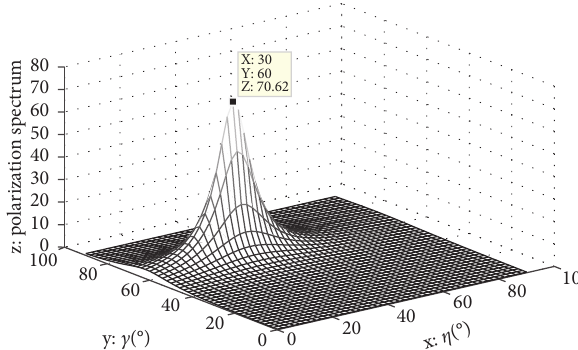
Figure 7: Polarization estimation with ( θ , ϕ ) � ( 65 ° , 40 ° ) .